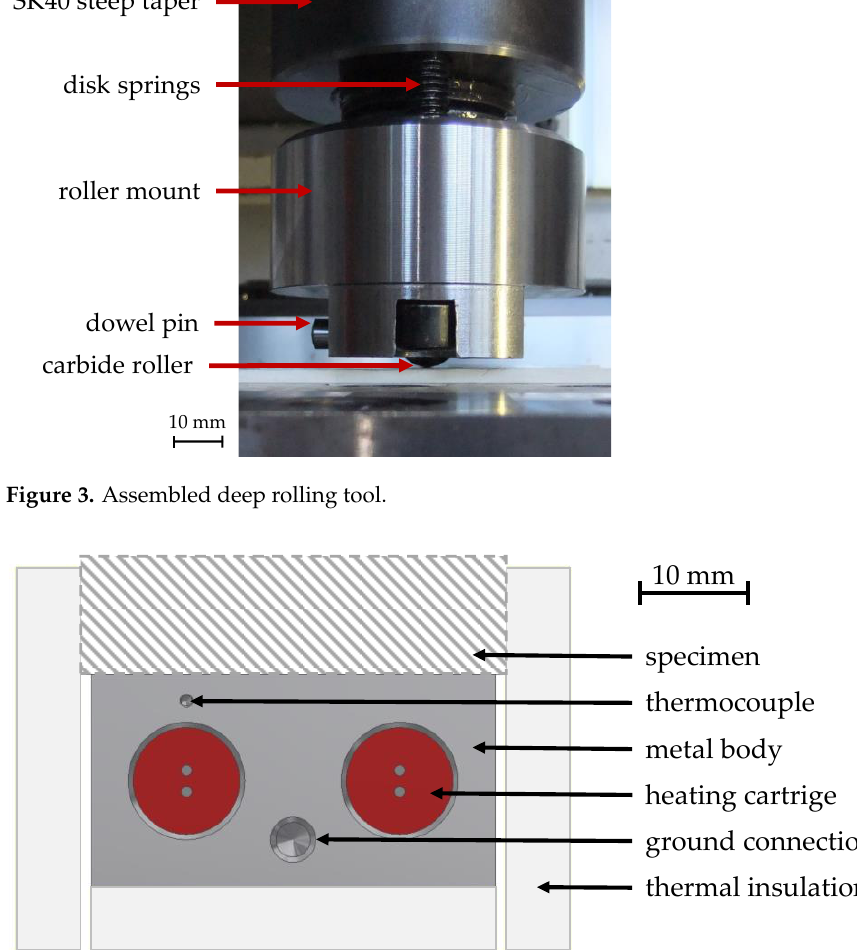
Figure 3. Assembled deep rolling tool.